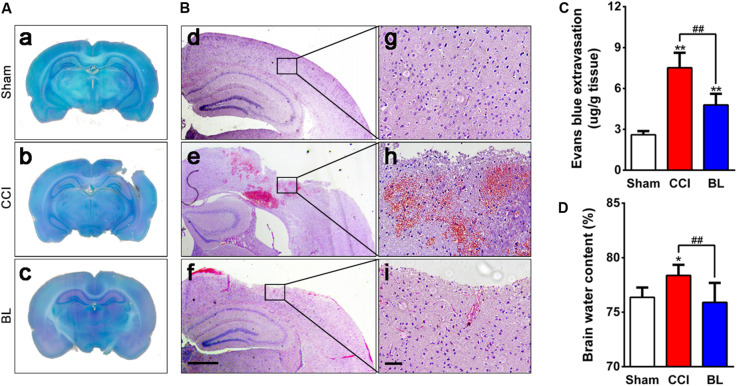
Effects of BL-HTWP on neurological damage and cerebrovascular histopathological changes post-TBI. Brain tissues were collected at 6 h after TBI. (A) Lesion assessment was performed on cresyl violet-staining brain sections. (B) Microbleedings were observed with hematoxylin and eosin (H&E) staining. (d–f) Representative images of contusion areas visualized with H&E staining. Scale bar, 250 μm. (g–i) Magnification of images shown in (d–f). Scale bar, 50 μm. (C) Blood–brain barrier permeability was measured by assessing the extravasation of Evans blue (EB) dye. (D) Cerebral edema was evaluated by water content of the brain tissue with the wet-to-dry weight ratio. Quantitative analysis (n = 4) were conducted by one-way ANOVA. *p < 0.05, **p < 0.01 vs. Sham; ##p < 0.01 vs. CCI.